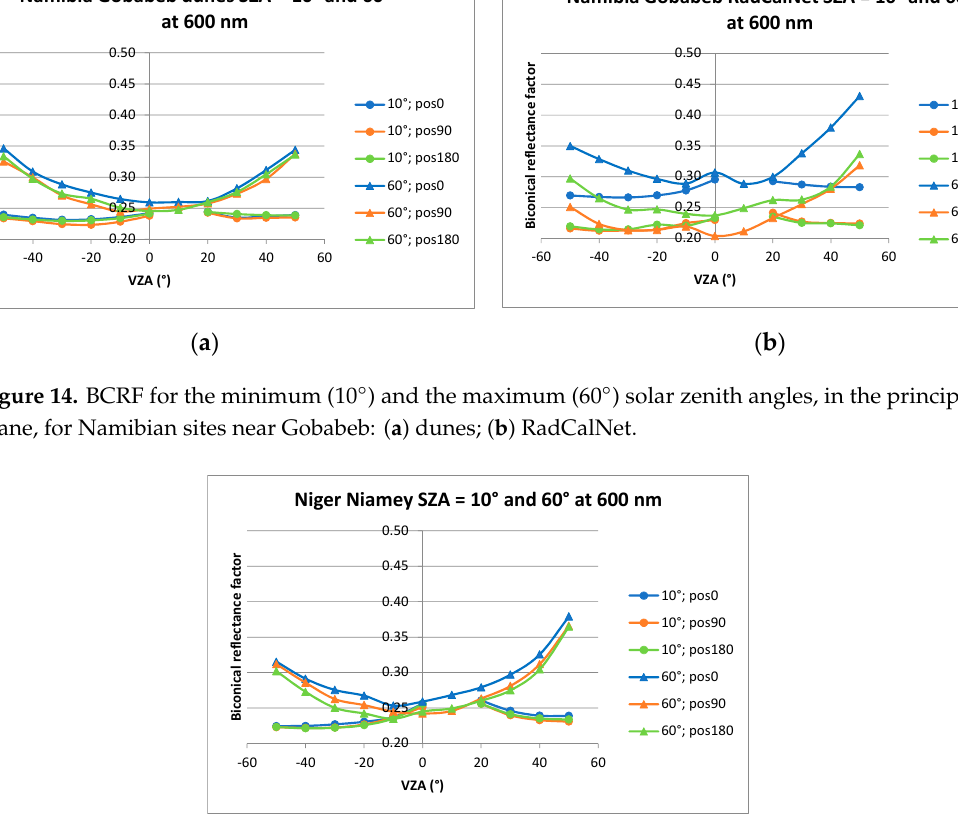
Table 3. List of the BRDF models and their characteristics.